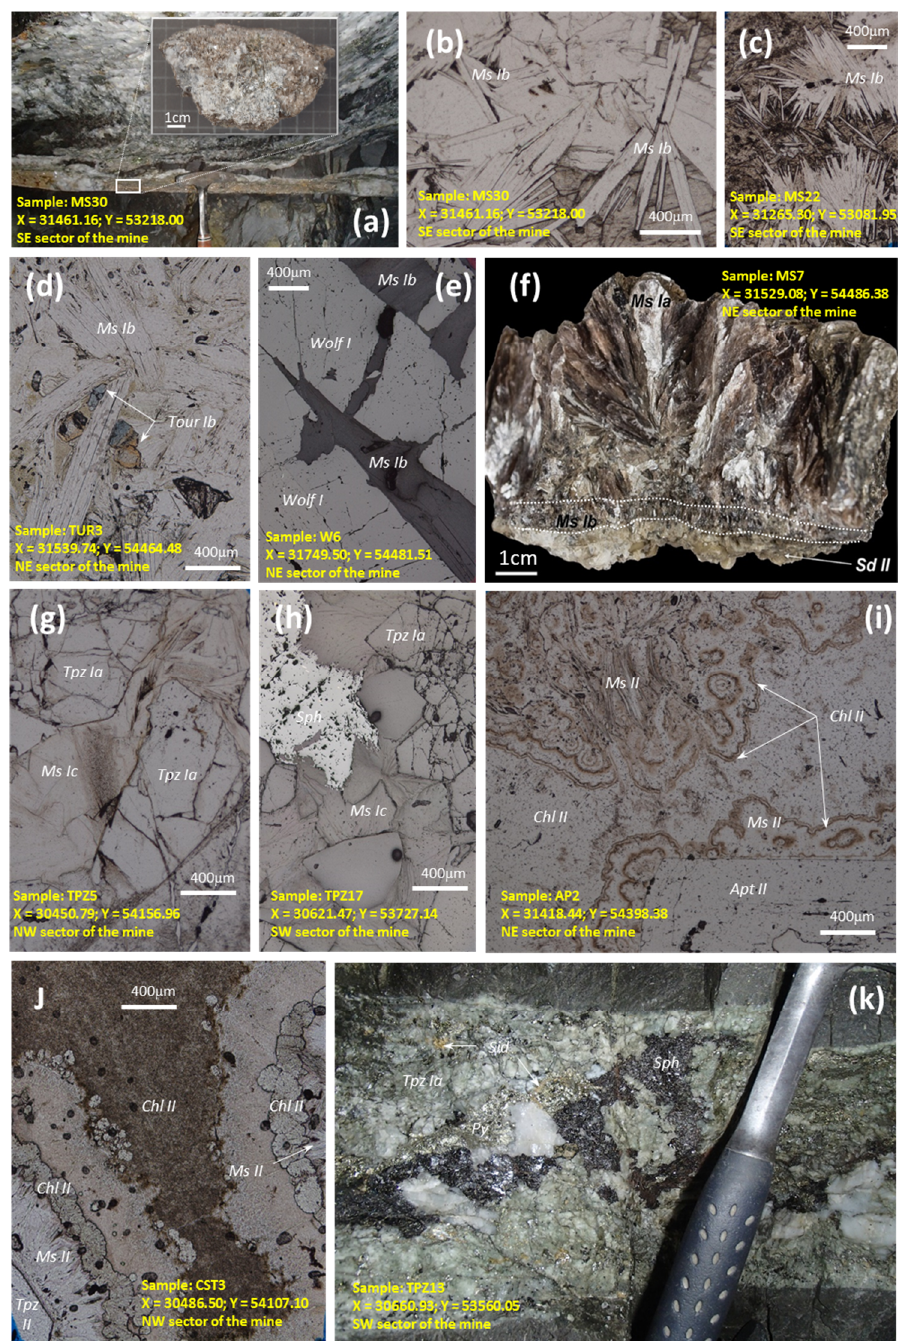
Figure 5. ( a ) Photograph of the quartz lode wherein the MS30 sample was collected, illustrating the features commonly observed in non-oriented bands of Ms Ib at the lode borders. ( b – e ) Photomicrographs (TM/PPL) documenting different arrangements of Ms Ib aggregates, sometimes coming along with accessory Tour Ib or forming fracture infillings affecting Wolf I . ( f ) Photograph of a hand specimen showing multiple reopening events at the lode wall, firstly decorated by a thick Ms Ia selvage criss-crossed at low angles by a veinlet of Ms Ib , later followed by deposition of (subhedral)-euhedral siderite ( Sid II ). ( g , h ) Photomicrographs (TM/PPL) exemplifying Ms Ic growth in intergranular spaces of Tpz Ia and Qz Ia (+ sphalerite ( Sph )) + Tpz Ia aggregates. ( i , j ) Photomicrographs (TM/PPL) documenting the typical arrangements of Ms II , bordered by Chl II . ( k ) Photograph of the lode wherein the TPZ13 sample was picked, providing evidence for an irregular reopening of a thick Tpz Ia selvage (including fine-grained Cst I ), followed by the deposition of quartz, sulfides (mostly pyrite ( Py ) and sphalerite ( Sph )) and accessory amounts of siderite ( Sid ).